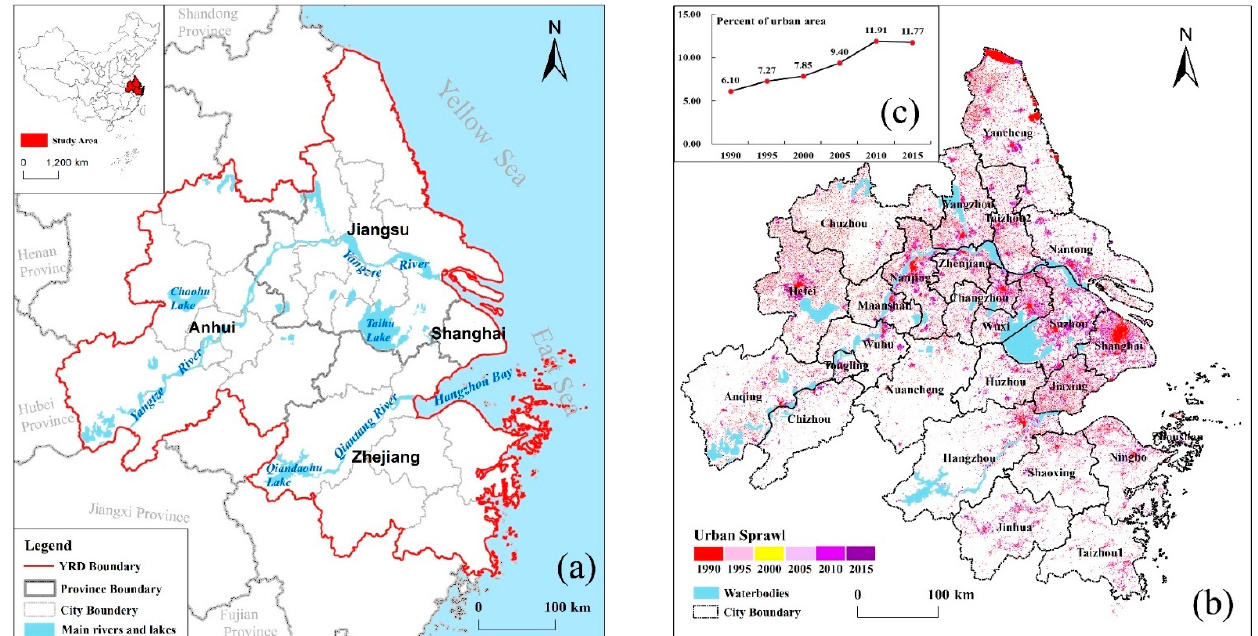
Figure 1. ( a ) Location of the study area; ( b ) urban sprawl in the YRD from 1990 to 2015; ( c ) the variation of percent of urban area of the YRD from 1990 to 2015.